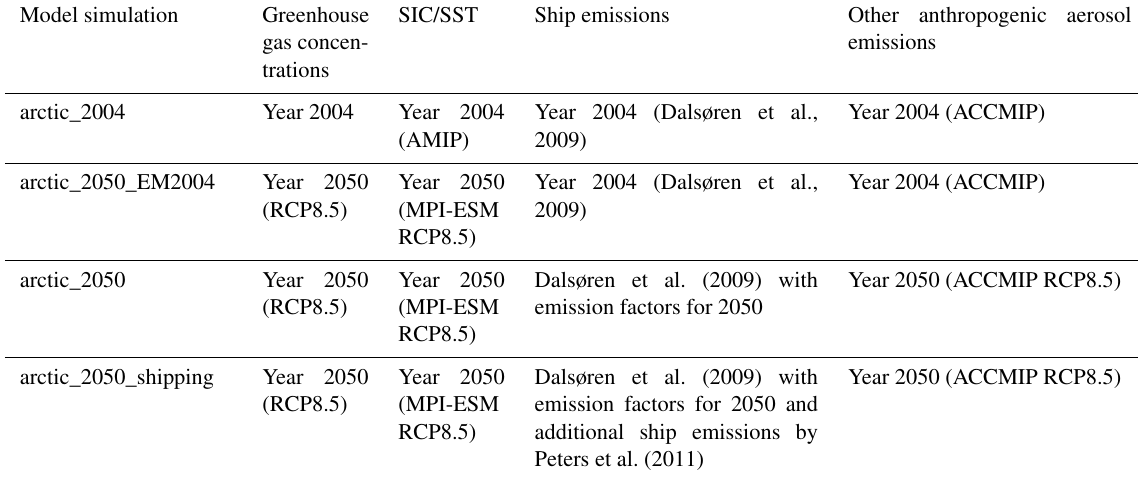
Table 1. An overview of the different model